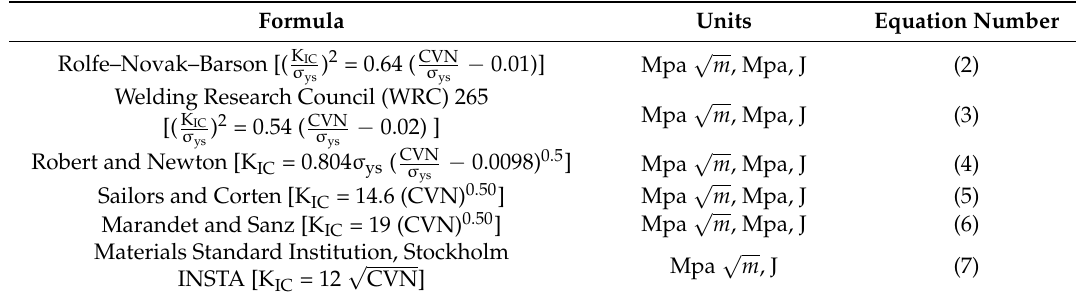
Table 5. Relationship between K IC –CVN (Source: Ter á n et al., [11]).